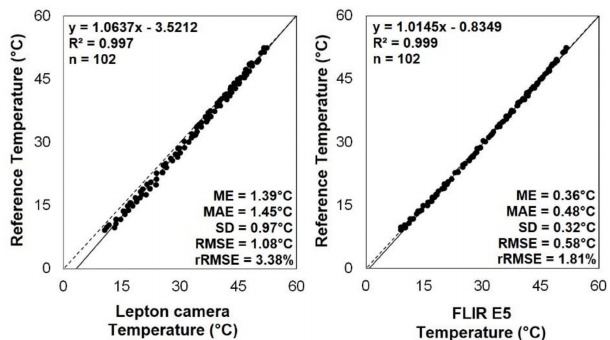
Figure 3. Linear regression models between TIR temperature and reference temperature readings for the Lepton camera and FLIR E5. Dashed line = 1:1 line; solid line = linear regression line; n = number of samples; R 2 = coe ffi cient of determination; ME = mean error; MAE = mean absolute error; RMSE = root mean square error; rRMSE = relative RMSE p < 0.001 for all R 2 .